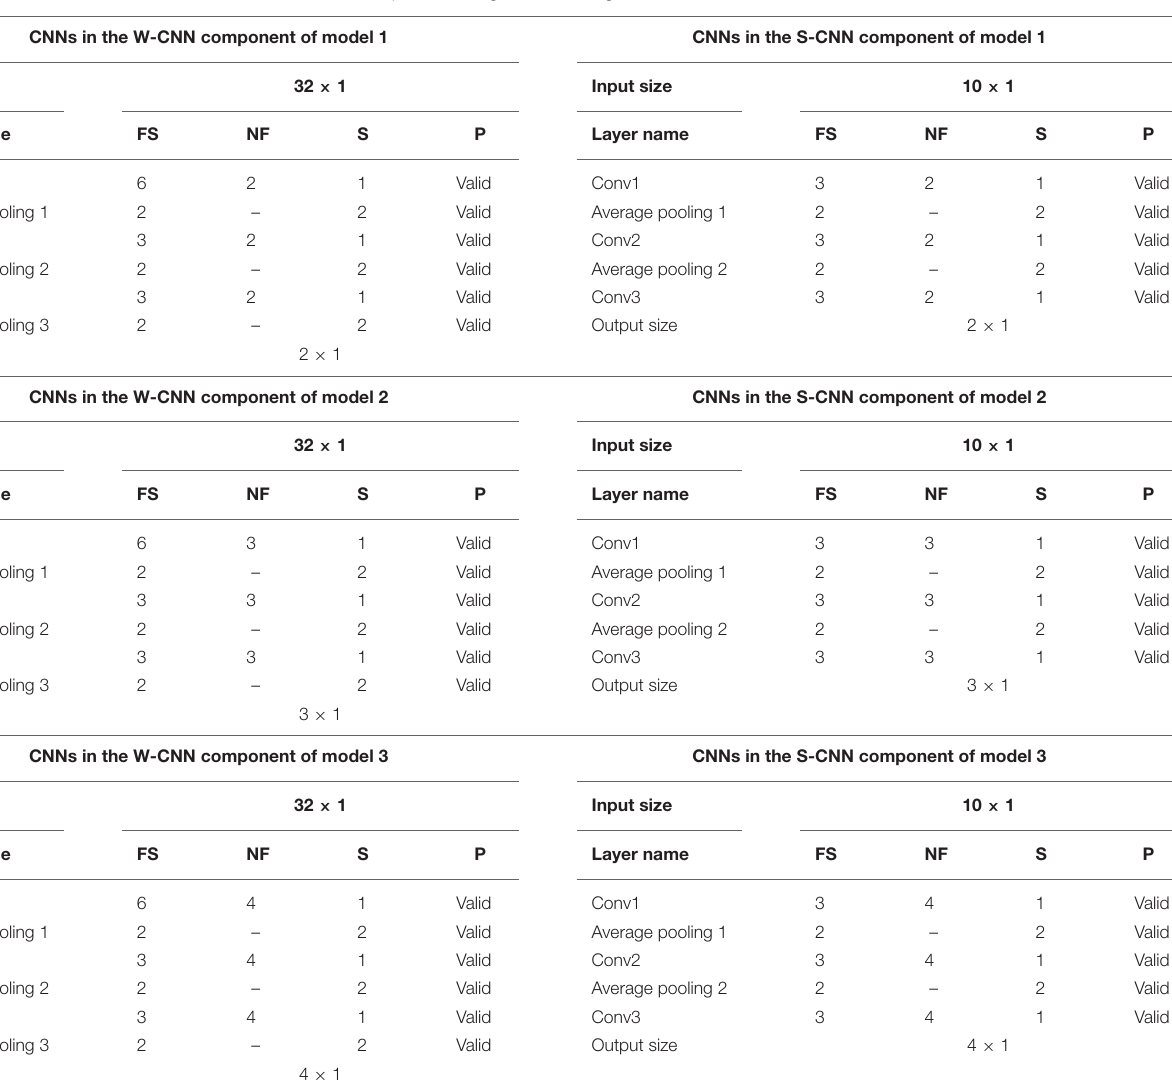
TABLE 2 | Detailed structure of the CNN networks of CNN components designed for heterogenous ensemble